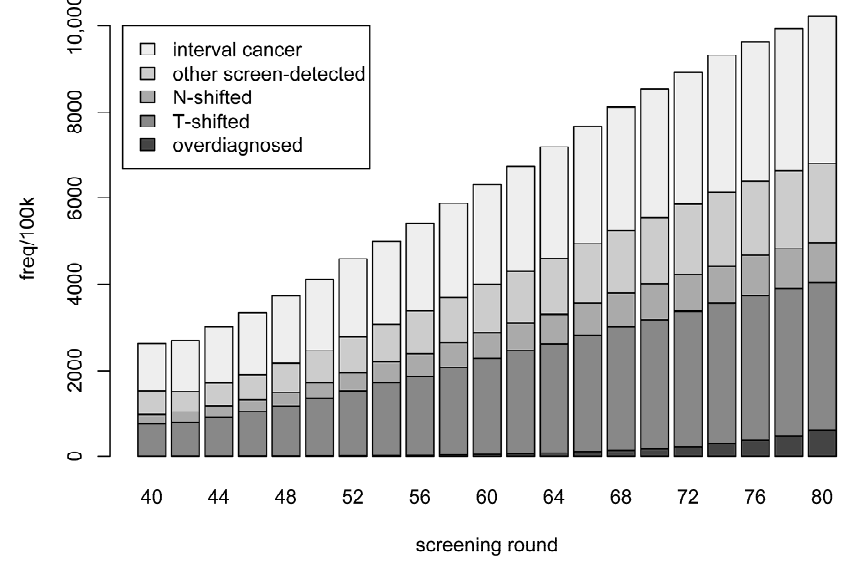
Figure 1. Categories of breast cancer cases detected in relation to each screening round. Categories are defined in the text. Frequencies are stacked and represent averages of ten simulations, each based on one million in silico individuals.